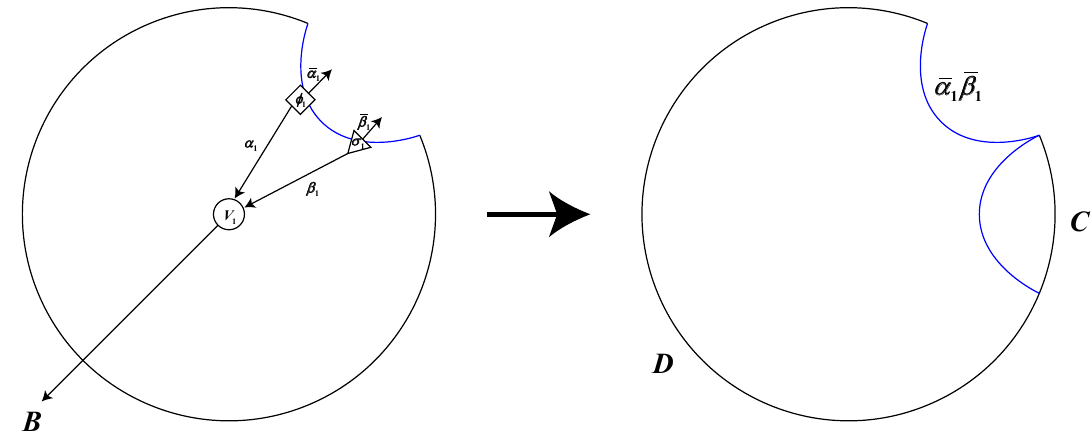
Figure 5 . By defining a subregion state Ψ V of the remaining region that has been cut off a small piece, we can apply the same bipartite distillation procedure to Ψ V .